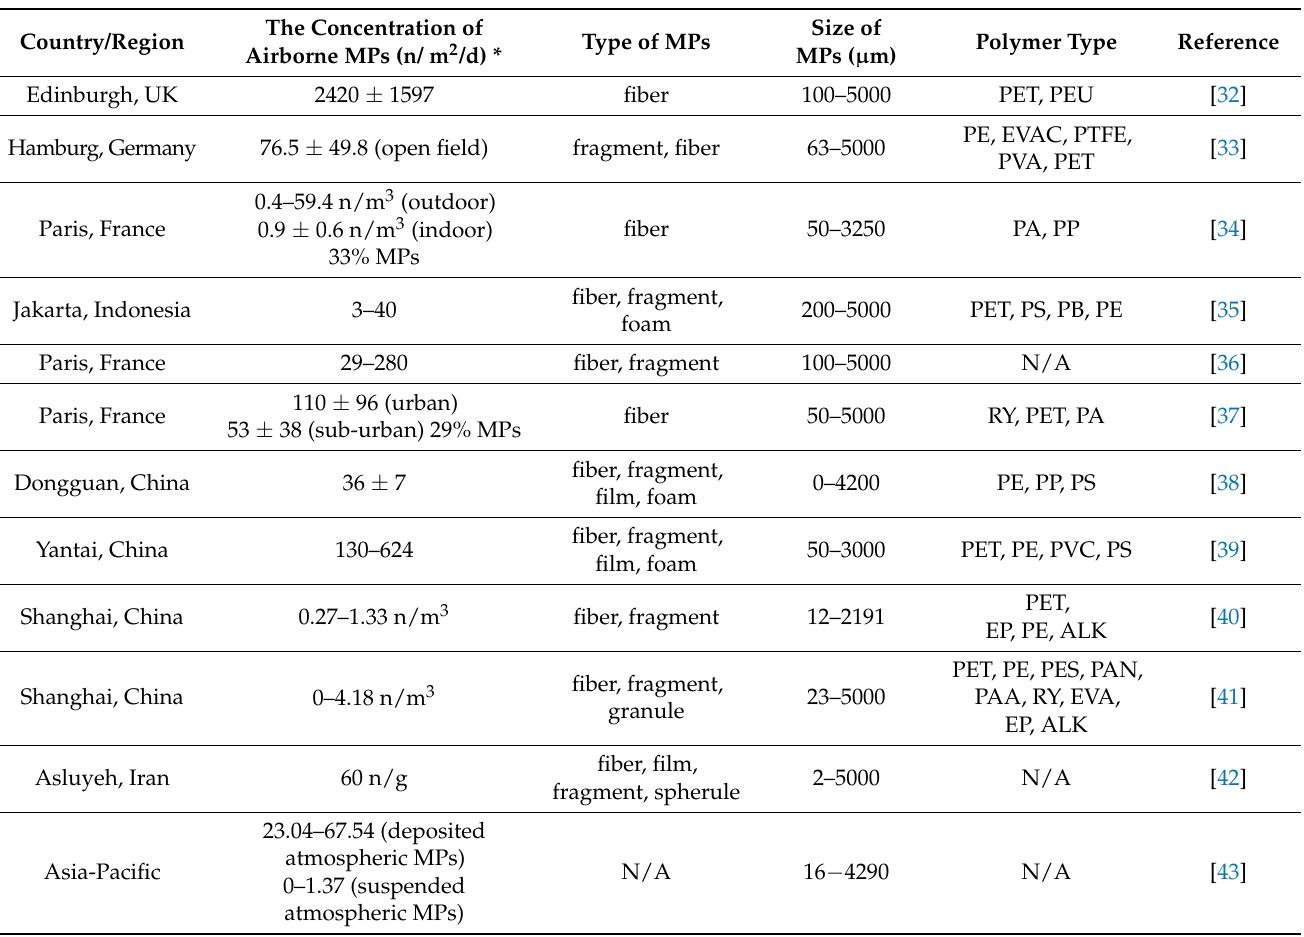
Table 1. The prevalence of airborne microplastics in different urban